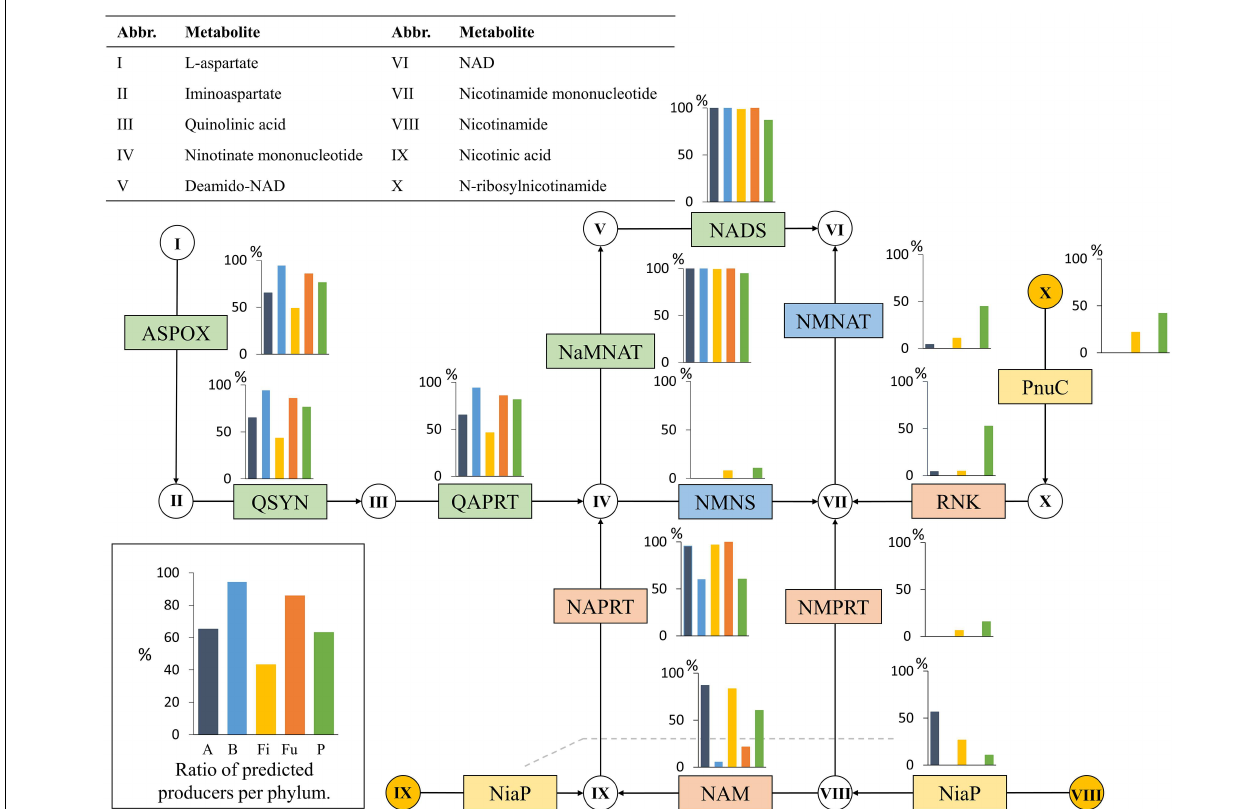
FIGURE 4 | Niacin biosynthesis. The niacin biosynthesis subsystem contains 14 functional roles (Supplementary Table 2) and 10 metabolites. Refer to Figure 1 for figure descriptions.